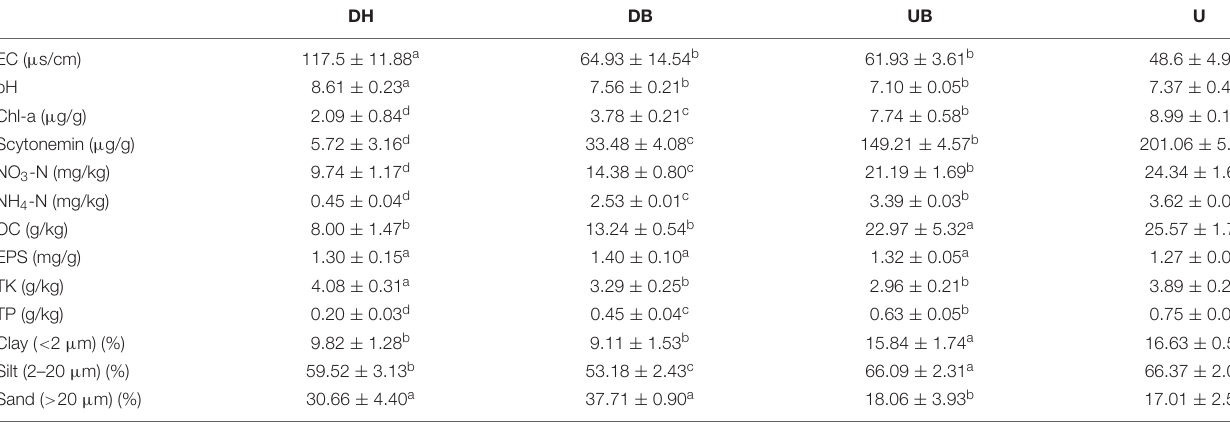
TABLE 2 | Biocrust physiochemical properties ( n =